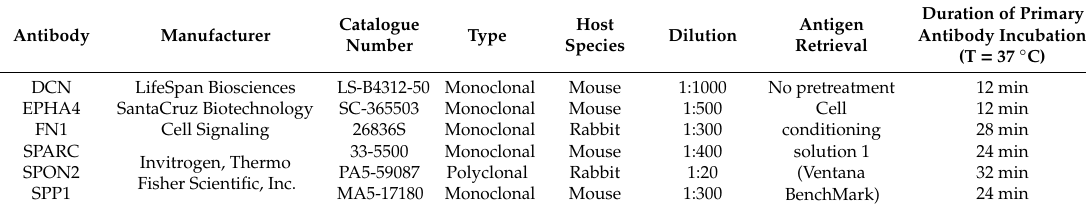
Table 4. Detailed information about the used antibodies for immunohistochemistry.